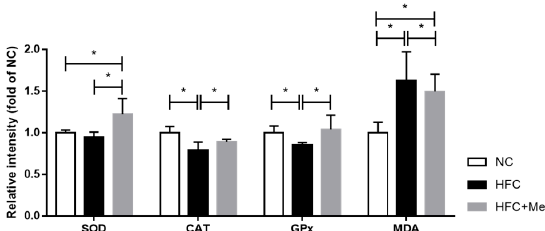
( a ) ( b ) Figure 6. Effects of the high-fat and high-cholesterol diet and metformin supplementation on testosterone biosynthesis regulators (StAR, CYP11A1, 3 β -HSD, CYP17A1 and 17 β -HSD) in the male mice: ( a ) Protein expressions in each group were measured using western blot analysis, and β -actin was used for normalization; ( b ) relative density analysis of the protein bands. Data are expressed as means ± SD of duplicate experiments ( n = 6–9 per group). * p < 0.05 as determined by one-way ANOVA followed by LSD post hoc test. NC, normal diet; HFC, high-fat and high-cholesterol diet; HFC + Met, HFC with metformin supplementation. 3.5. Metformin Suppresses the Oxidative Stress Level in the Testis but Dose Not Reverse the Testicular Apoptosis and Inflammation